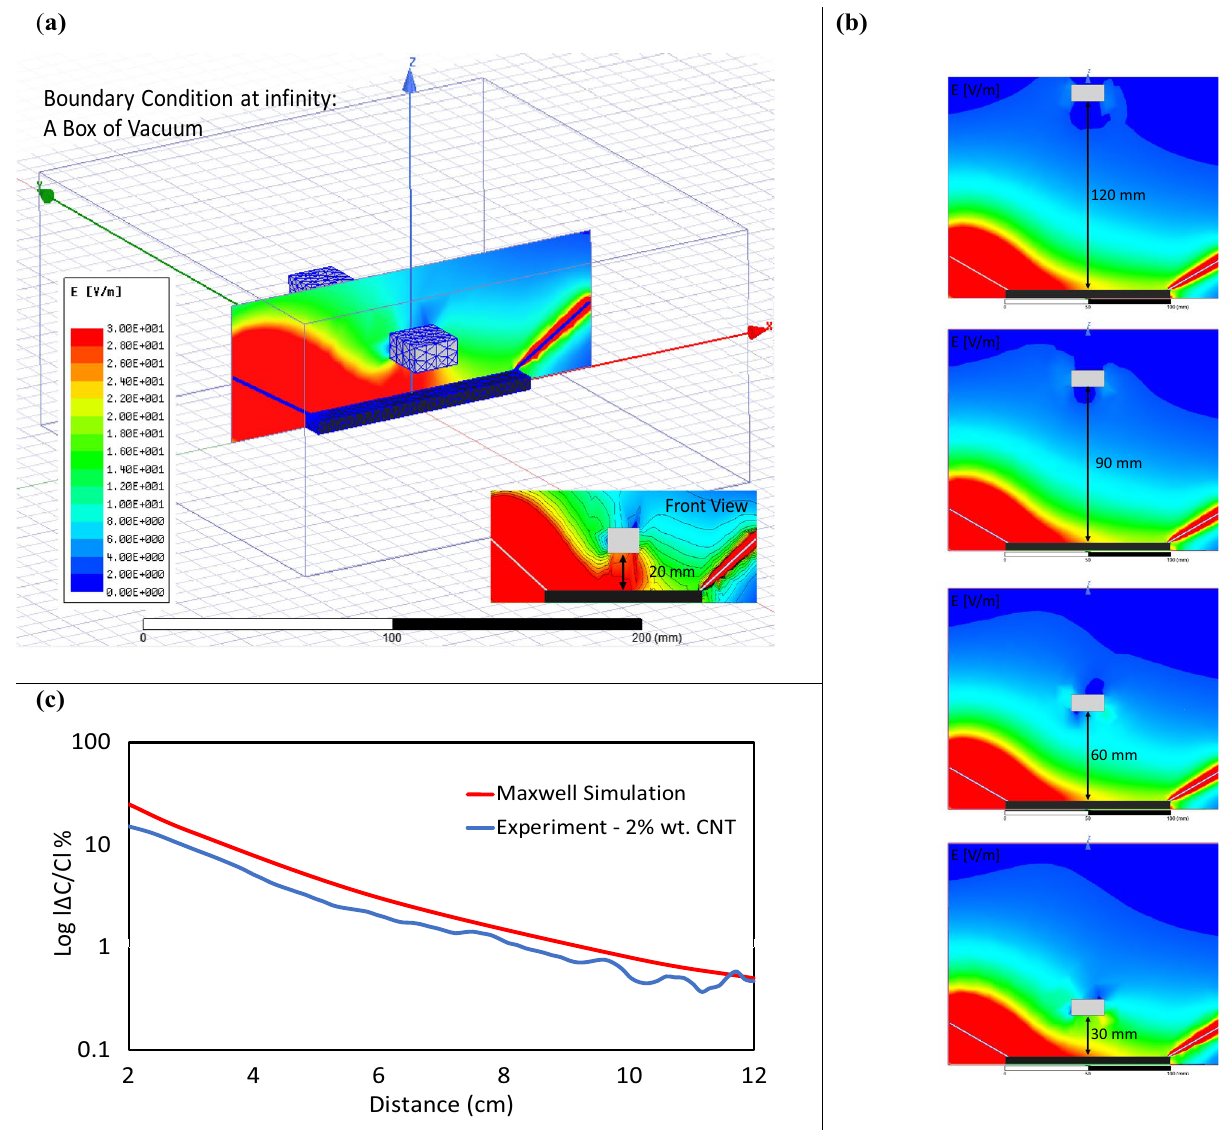
Figure 5. Schematic representation of simulation results of the basic fringe field cell. ( a ) A simple 3D model in Ansoft Maxwell along with implemented material properties, boundary conditions, vacuum domain, mesh and voltage distribution of sensor at closest proximity to the sensor (20 mm) inside a vacuum box. ( b ) Voltage distribution between two probes in range of 120 mm to 30 mm. Capacitance between two probes is mainly determined by fringe effects. ( c ) Experimental and Maxwell simulation comparison of capacitance change as a function of